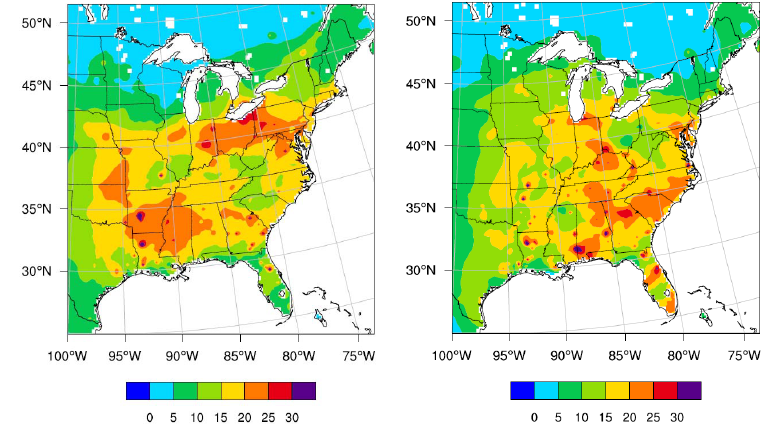
Figure 3. 24h average PM 2 . 5 concentrations (µgm − 3 ) for 29 June (left) and 5 July 2012